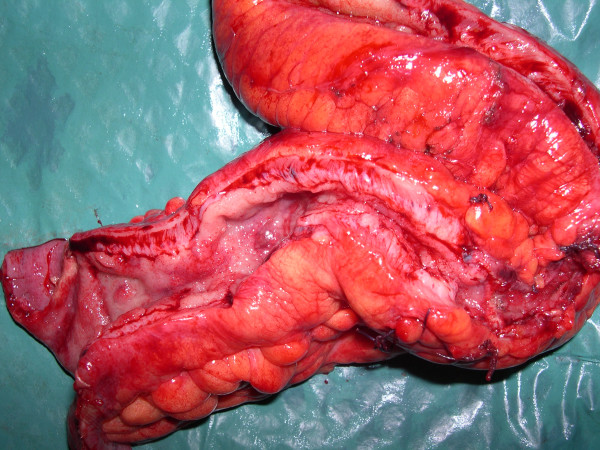
The ileal loop shows an important thickness of the wall with disappearance of the normal mucosal plicae.